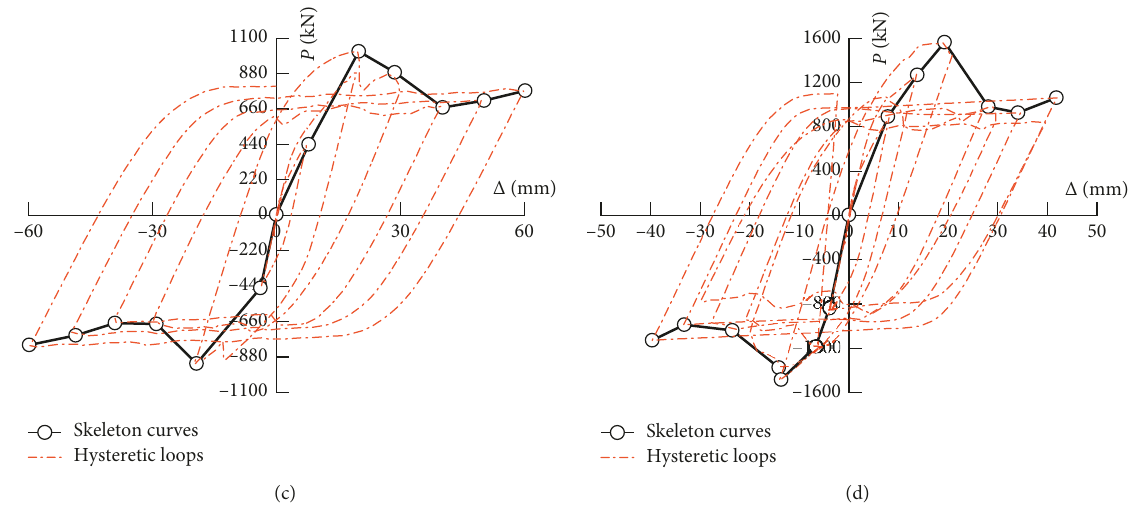
Figure 14: Load-displacement and hysteretic loops skeleton curves of newly designed joints of SRCFCST. (a) SRCTJ1. (b) SRCTJ2. (c) SRCTJ3. (d) SRCTJ4. Table 6: Comparison of finite element and theoretical calculations of shear bearing capacity.